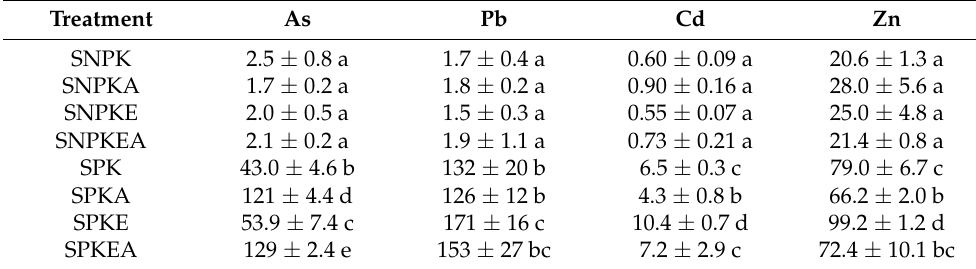
Table 3. Total concentration (mg kg − 1 DW) of heavy metal (As, Pb, Cd, and Zn) in the root of K. pentacarpos exposed to non-polluted or polluted soil in the presence or in the absence of NaCl or/and EDDS for five months. Each value is the mean of 3 replicates and vertical bars are S.E. Values exhibiting different letters are significantly different at p < 0.05 according to SNK test. Treatment As